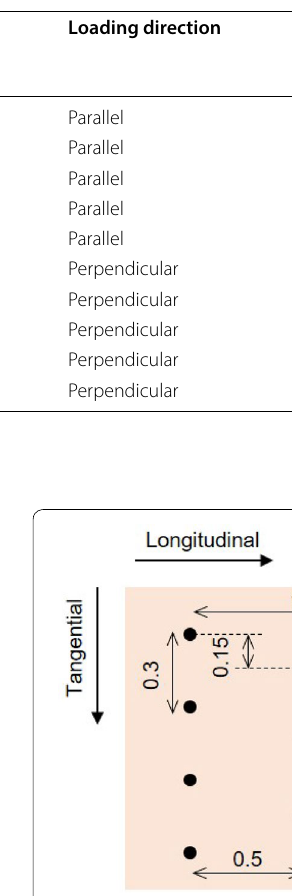
Table 1 Summary of joint specimen groups